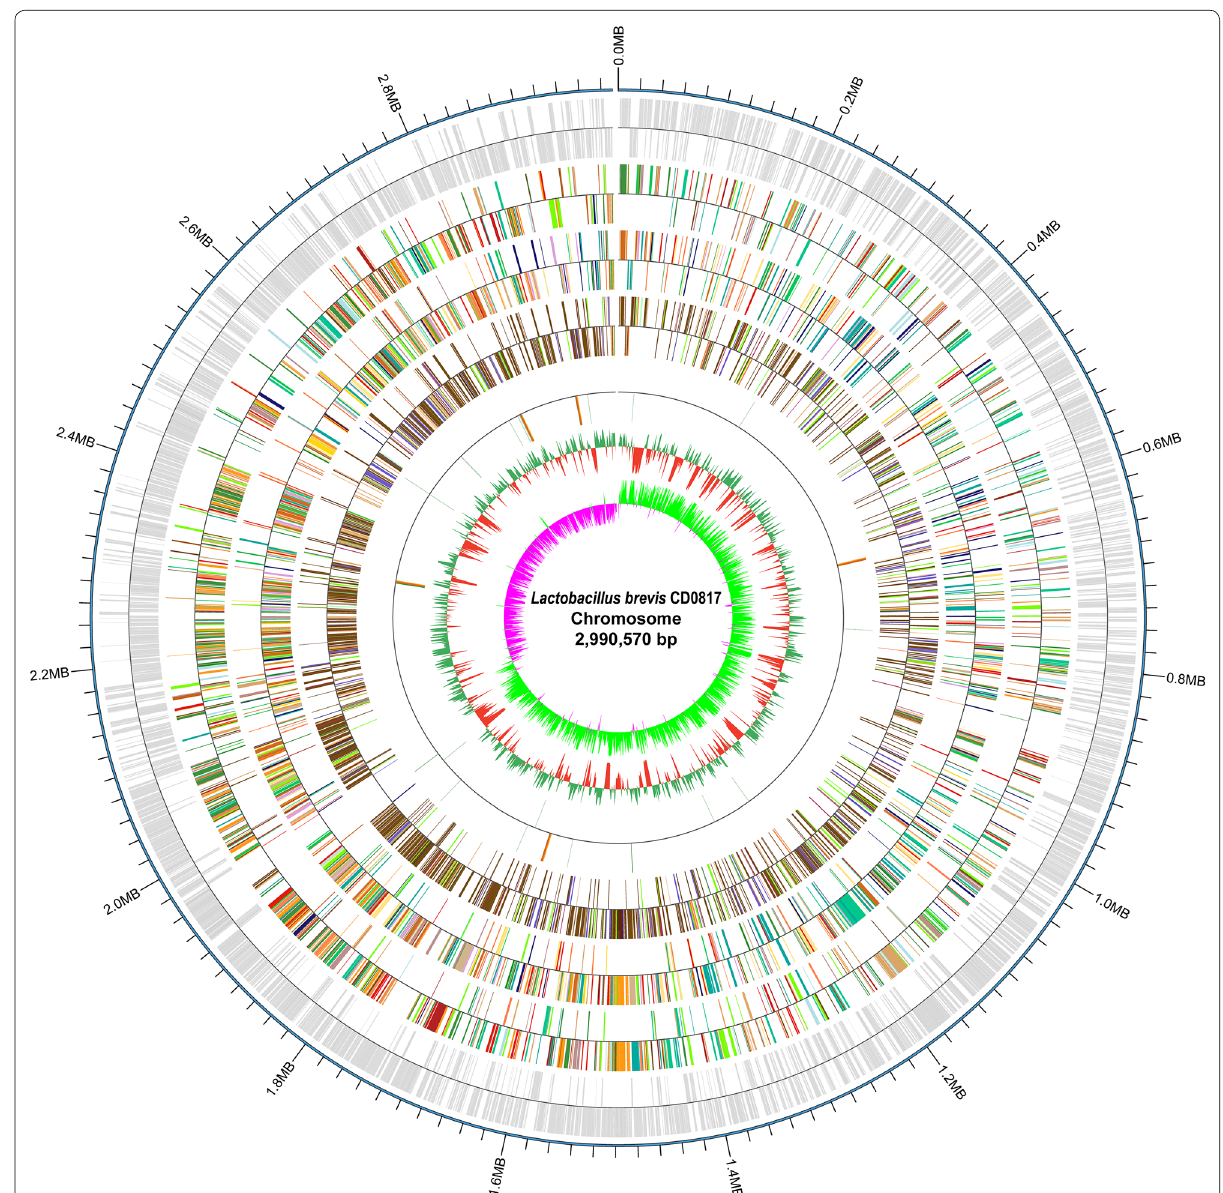
Fig. 1 Graphical circular map of CD0817 chromosome. The 13 concentric circles represent the following (from outermost to innermost): circle 1, DNA base position; circles 2 and 3, protein-coding genes on forward and reverse strands; circles 4 and 5, COG functional classification of protein-coding genes on forward and reverse strands; circles 6 and 7, KEGG functional classification of protein-coding genes on forward and reverse strands; circles 8 and 9, GO functional classification of protein-coding genes on forward and reverse strands; circles 10 and 11, rRNA (5S, 16S and 23S), tRNA and sRNA genes on forward and reverse strands; circle 12, relative G and lower than average value of 50.63%, respectively; circle 13, GC skew ([G (representative of leading strand) and negative (representative of lagging strand) values,